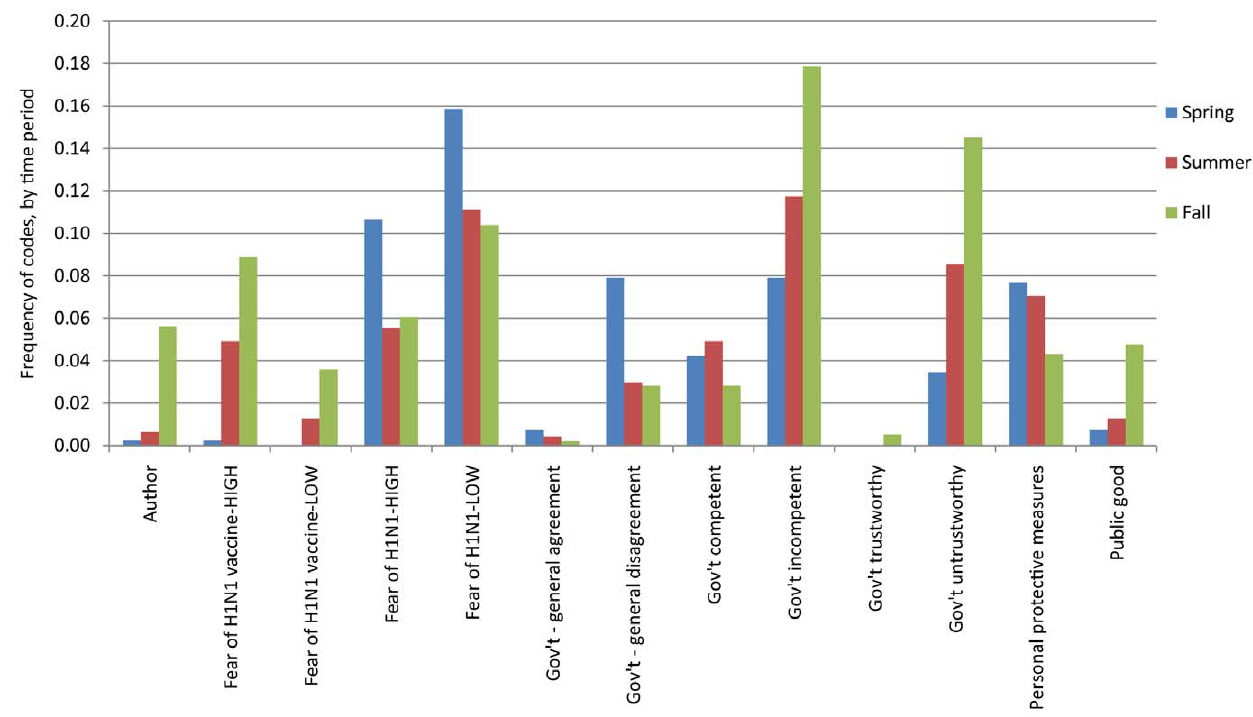
Figure 1. Coding by time period for themes with a consistent trend over time. Frequency of codes associated with the 8 themes that showed a consistent increase or decrease across time periods, by time period.